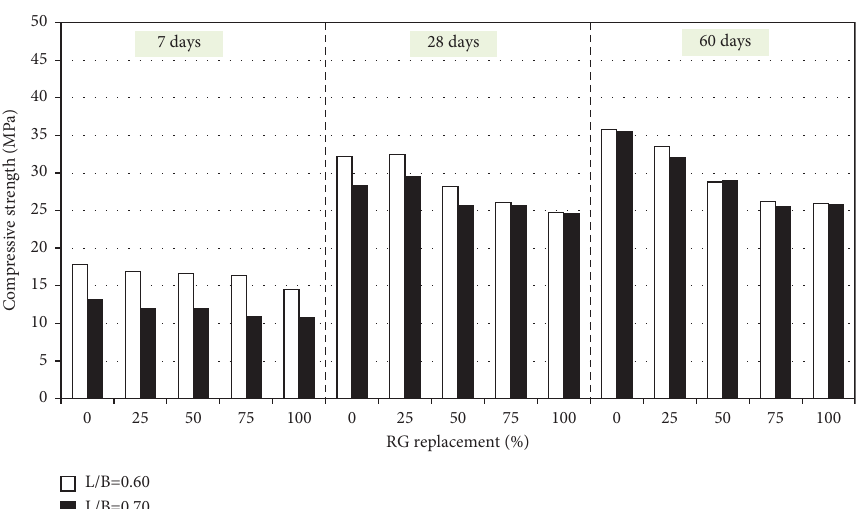
Figure 3: Compressive strength of AAFA mortar containing RG under diferent curing times and L/B